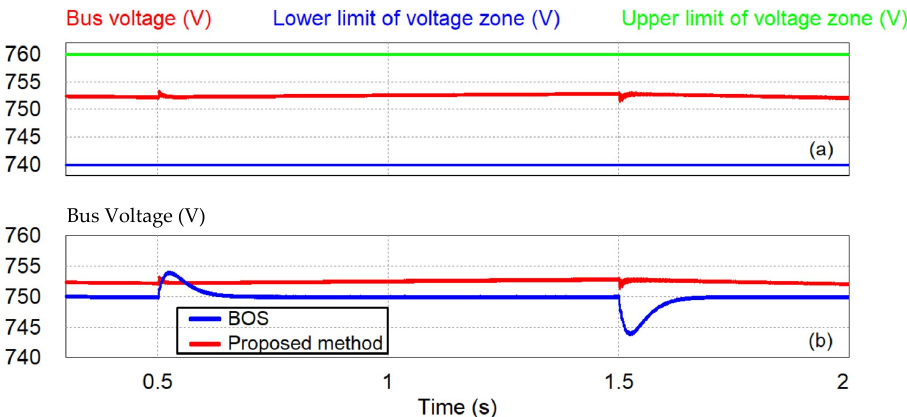
Figure 10. ( a ) The DC bus voltage and the corresponding limits in the proposed method; ( b ) the DC bus voltage in both methods—Case 1.